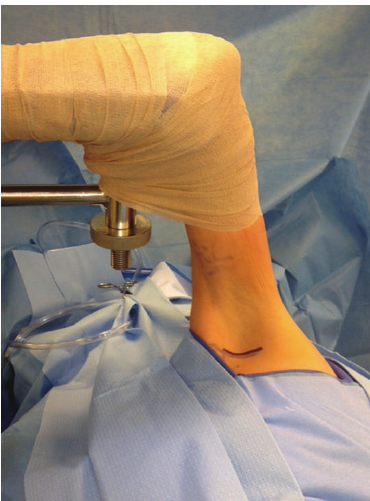
Figure 3: Machleder retractor with incision marked just below axillary hair line.